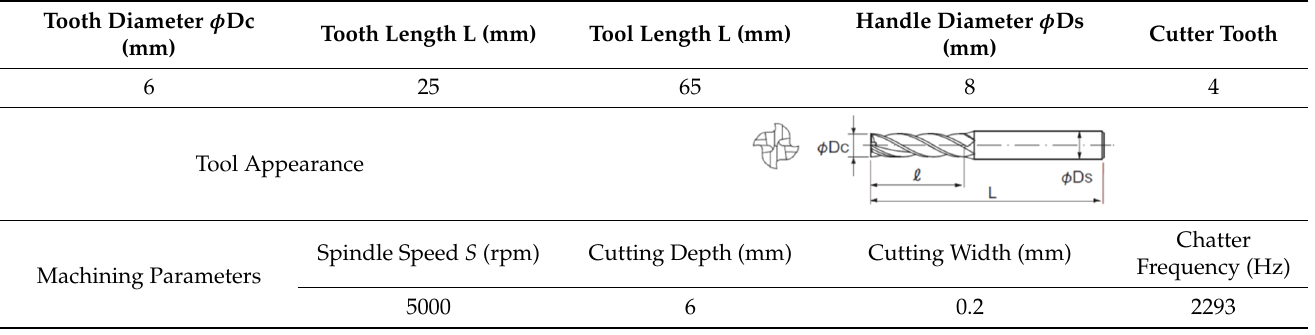
Table 4. Specifications of the Nachi LIST 6212 cutter and the machining parameters.